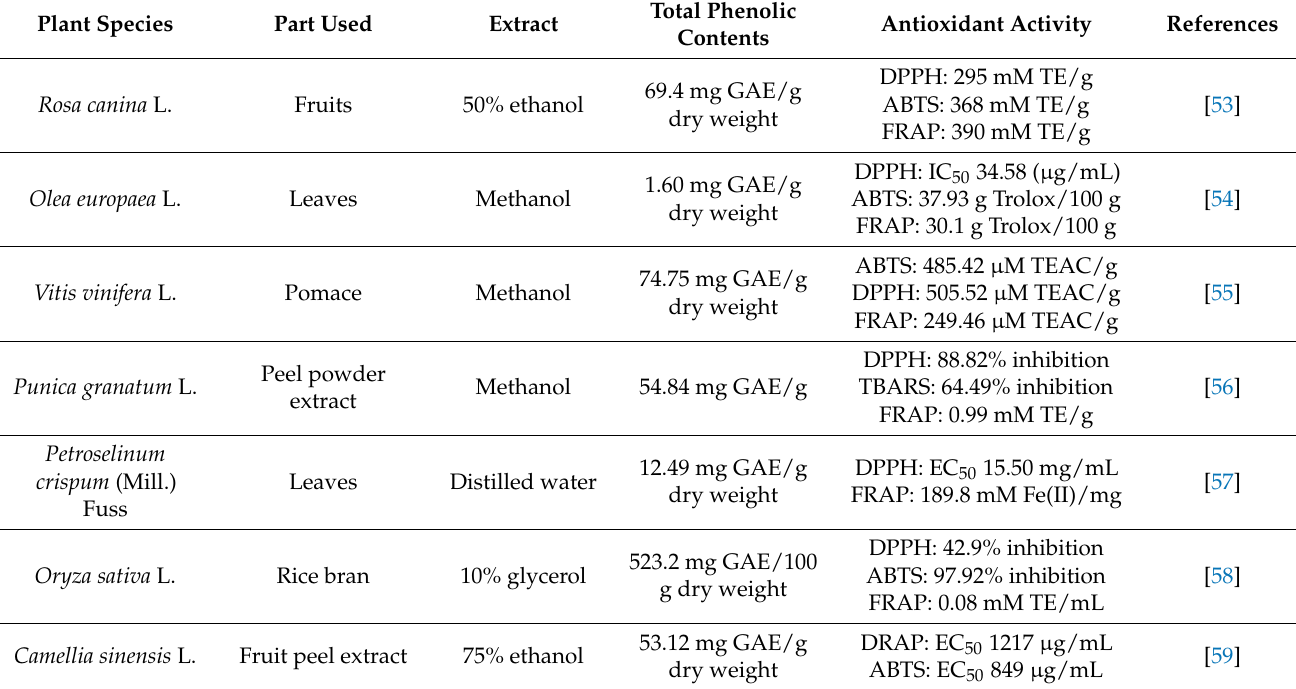
Table 1. Antioxidant potential of some selected botanical